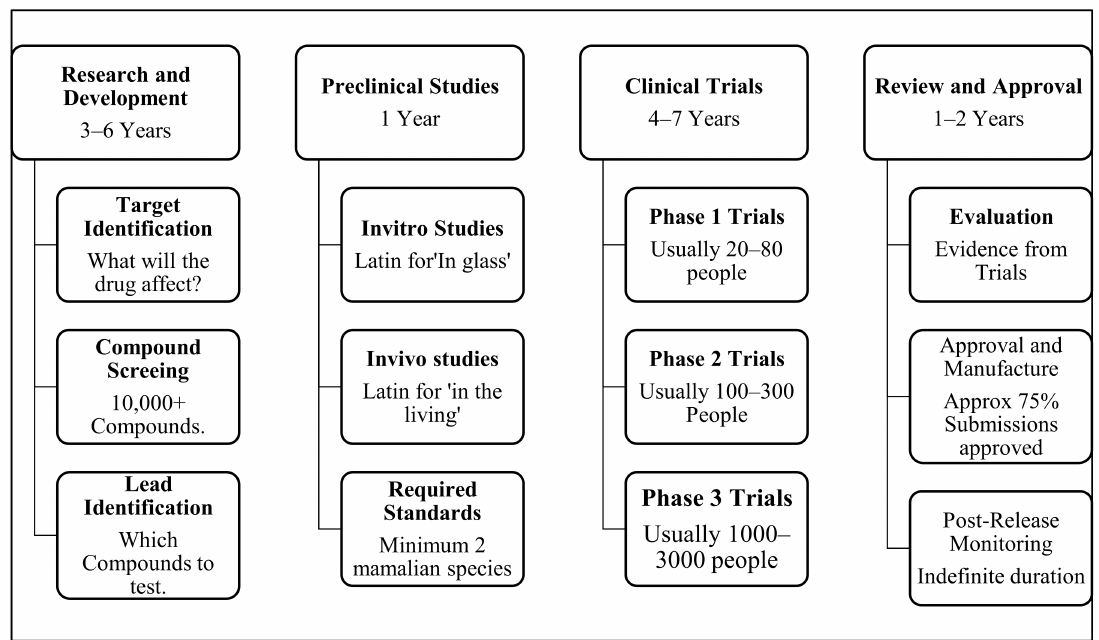
Figure 2. Traditional drug development process. Source: Author’s Analysis Information was adapted from Harrus and Wyndham